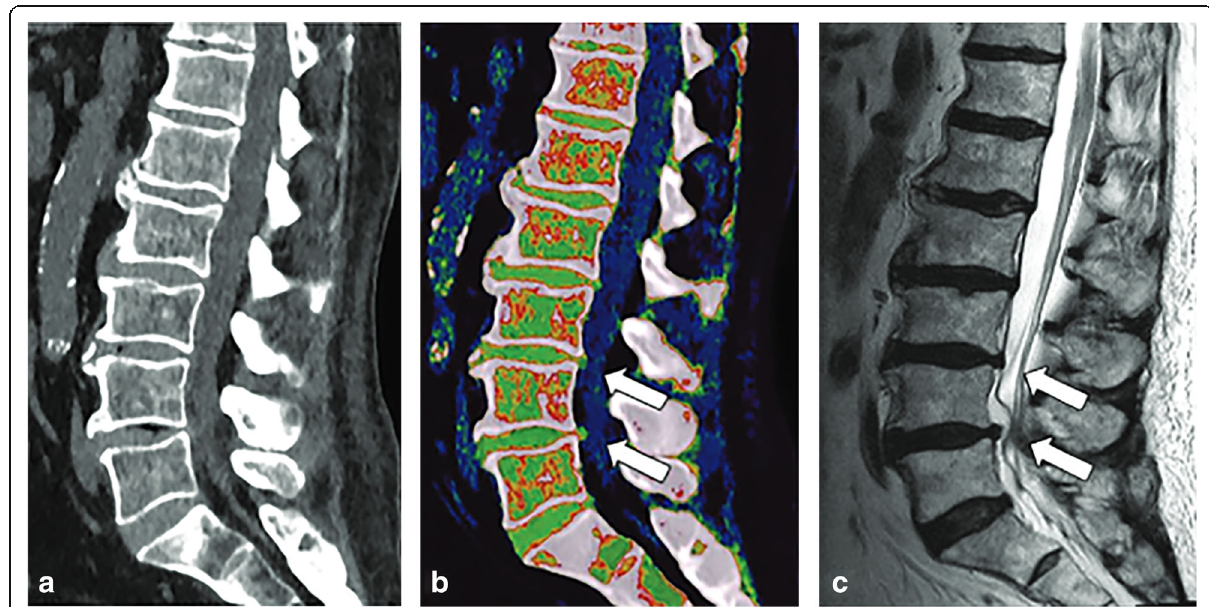
Fig. 3 Spine dual-energy computed tomography. Standard grayscale series ( a ) shows typical findings of spondylarthrosis with vacuum phenomena in L3/L4 and L4/L5 intervertebral discs. Virtual non-calcium reconstruction with optimization for intervertebral disc analysis ( b ) can finely show the protrusion of lumbar discs ( arrows ), confirmed by magnetic resonance imaging T2-weighted sequence ( c ) ( arrows ). From Booz et al.